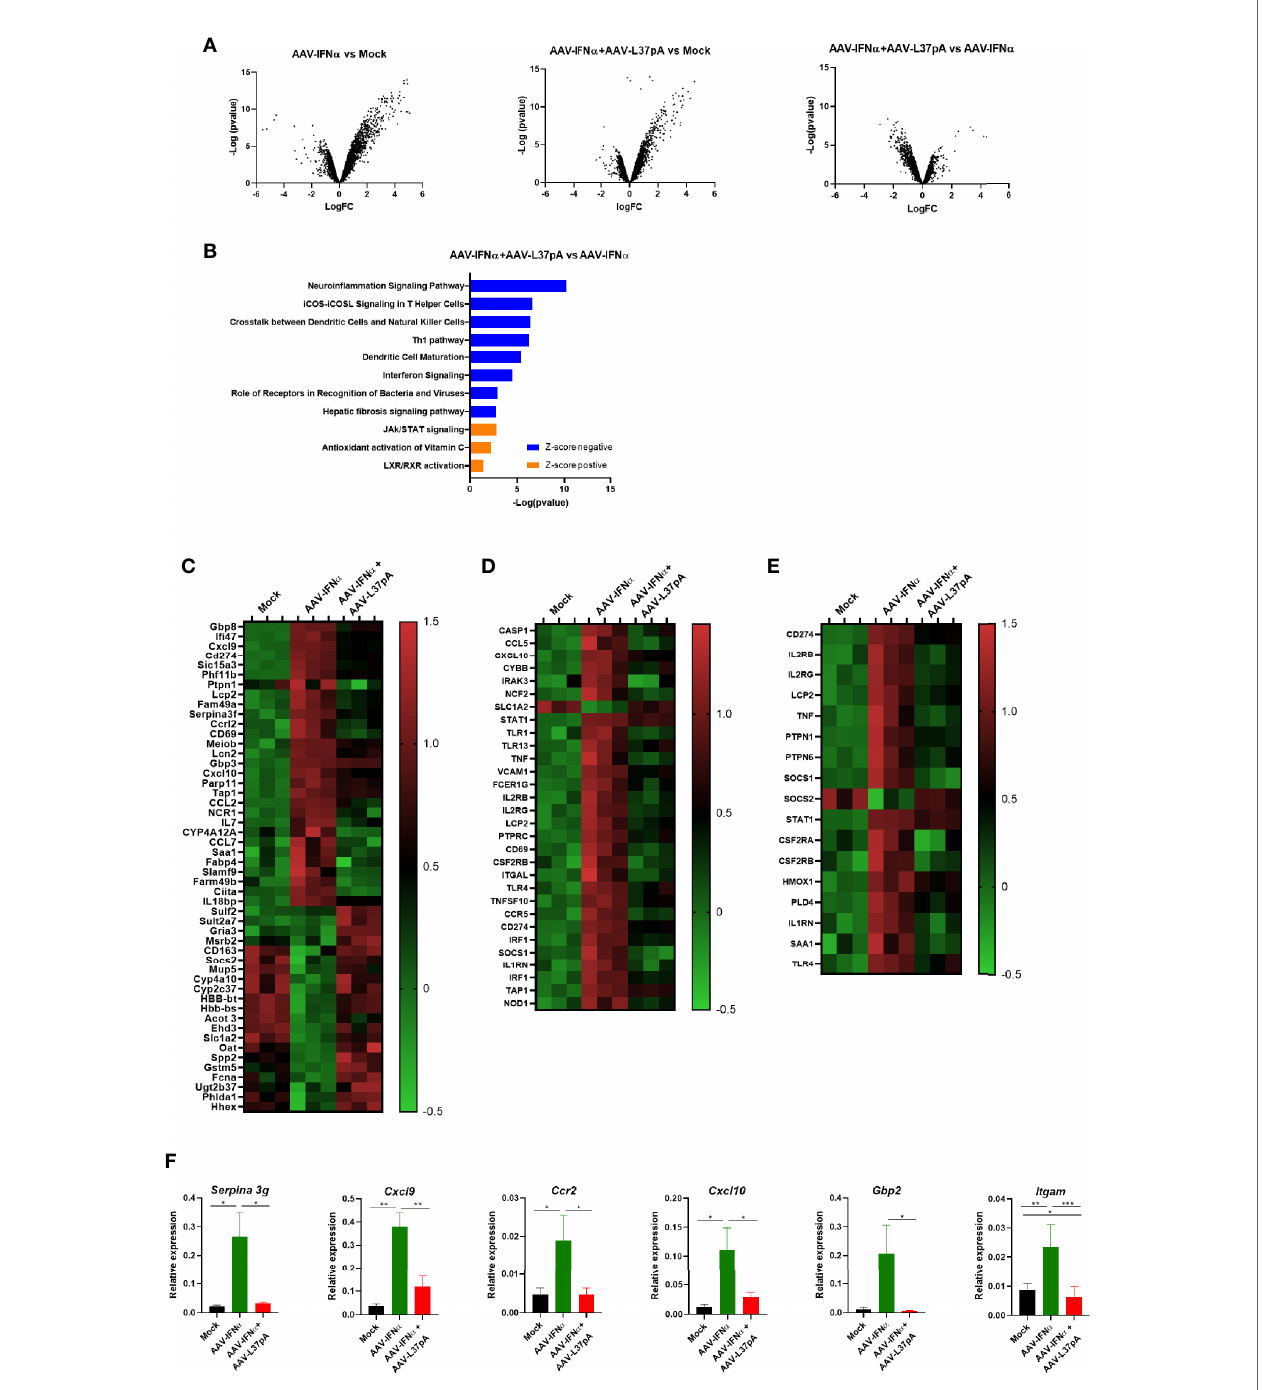
FIGURE 3 | Coadministration of AAV-IFN a and AAV-L37pA modify the gene expression program modulated by AAV-IFN a in the liver. mRNA was isolated from the liver as described in Figure 2A and differentially expressed genes were analyzed by microarray analysis. (A) Volcano plot of differentially expressed genes in the liver of mice untreated (Mock), treated with AAV-IFN a or AAV-IFN a and AAV-L37pA. (B) Top signi fi cantly affected pathways based on Ingenuity pathway analysis (IPA). The horizontal bars denote the different pathways based on the z-score. Orange color indicates upregulation, while blue color indicates downregulation. (C) Heat map representing the relative expression of most differentially expressed genes. (D) Heat map representing the relative expression of genes contributing to the pathways with a negative Z-score. (E) Heat map representing the relative expression of genes contributing to the pathways with a positive Z-score. (F) Validation of relevant differentially expressed genes by RT-qPCR. Mean ± SEM is represented. *p < 0.05, **p < 0.001, ***p < 0.001 One-way ANOVA followed by Tukey ’ s multiple comparisons